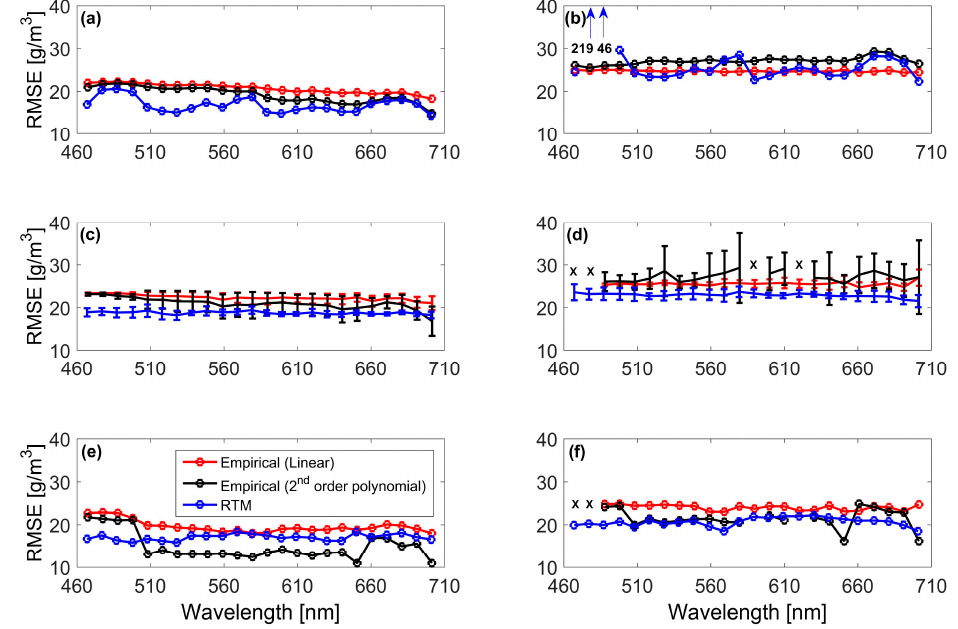
Figure 8. Root-mean-square error (RMSE) obtained from calibration ( a , c , e ) and validation ( b , d , f ) of the inversion of the radiative transfer model (Equation (8)) using: single Hyperion band ( a , b ); two Hyperion bands with mean and one standard deviation that is denoted as error bar ( c , d ) and minimum ( e , f ), computed at a spectral band using all the possible pairs of that spectral band with the other. Out of range data (indicate complete model failure) are represented with an arrow and the corresponding RMSE values are reported next to it, spectral bands fail with empirical models are marked as a black cross.